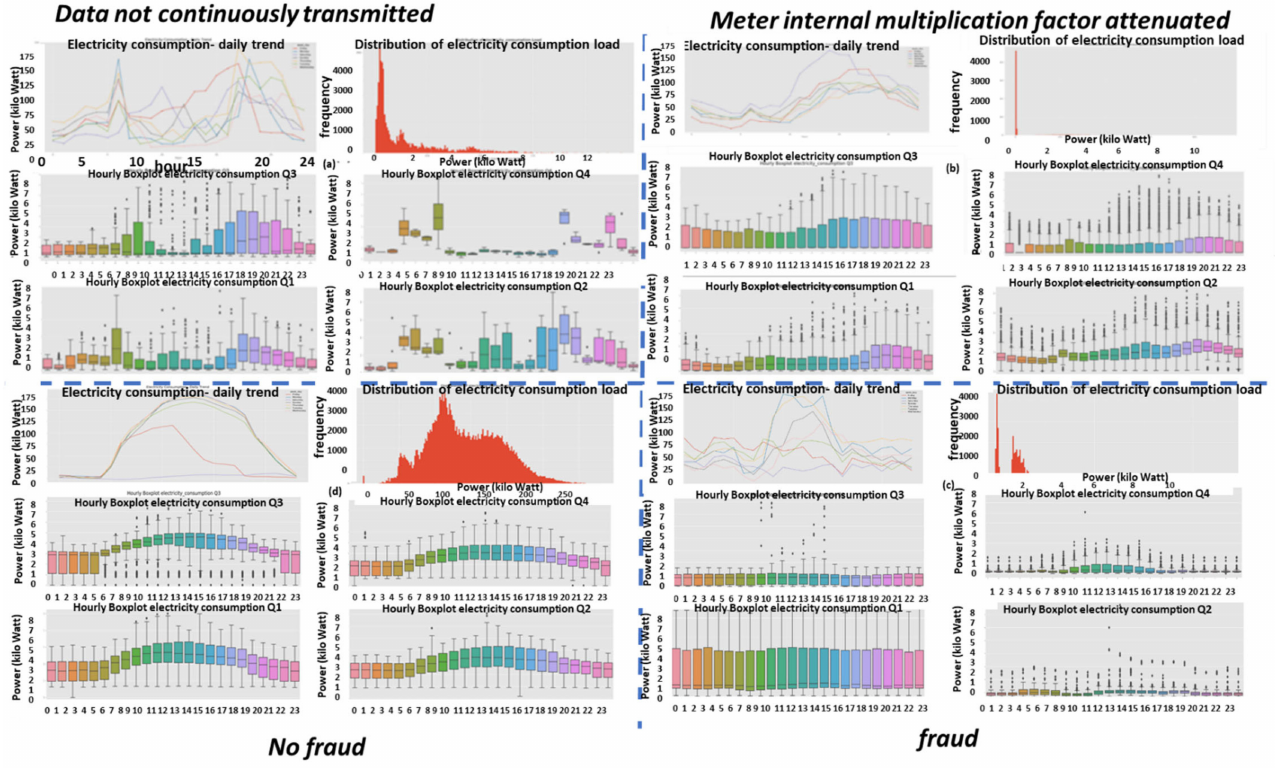
Figure 26. Characteristic signatures. Top left clockwise to bottom left signatures of ( a ) “data not continuously transmitted from MDM to data warehouse” failure, ( b ) meter internal multiplication factor attenuated due to firmware bugs, ( c ) verified fraud, ( d ) verified